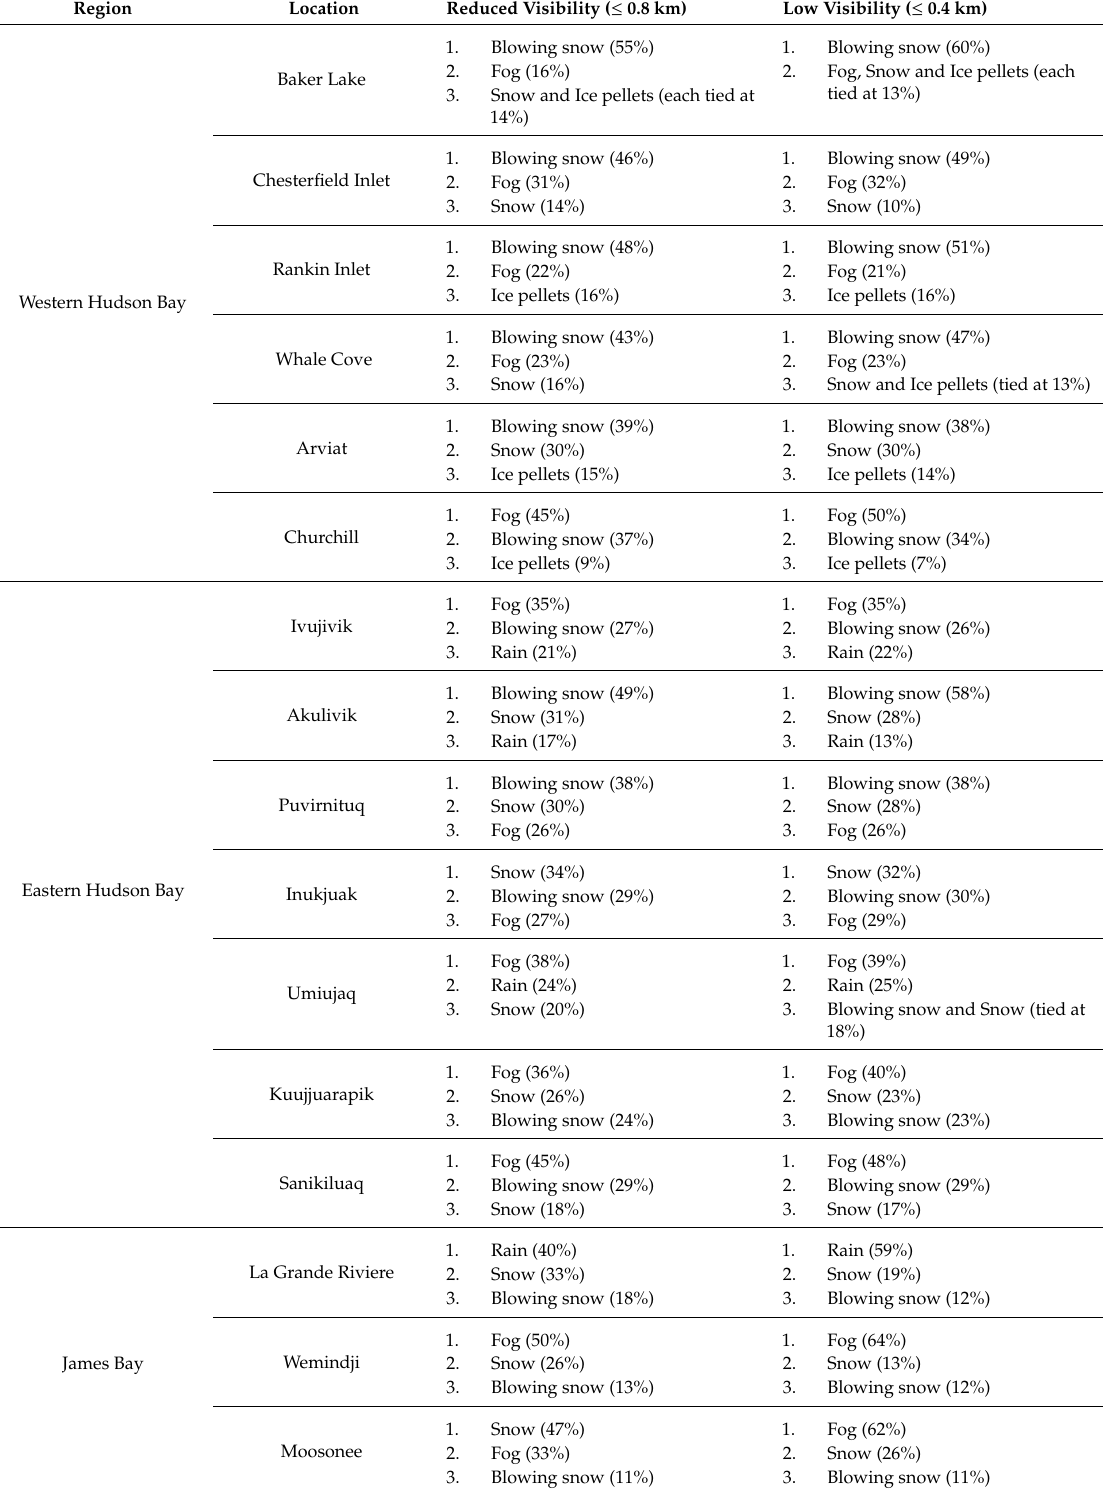
Table 7. Top three causes and their proportions for reduced and low visibilities at study airports. Total percentages can exceed 100% as multiple weather events can be recorded within the same hour.